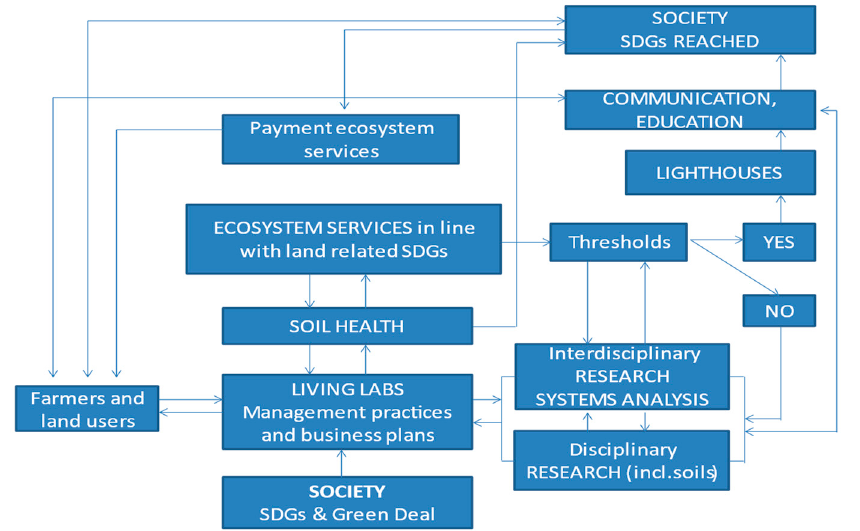
Figure 1. Schematic representation of contributions by ecosystem services to achieving environmental aspects of relevant SDGs. The diagram refers to an entire farming system studied in Living Labs, where soil science makes contributions, as well as other disciplines. When Living Labs satisfy all thresholds of the ecosystem services, a Lighthouse is established (from [15]).